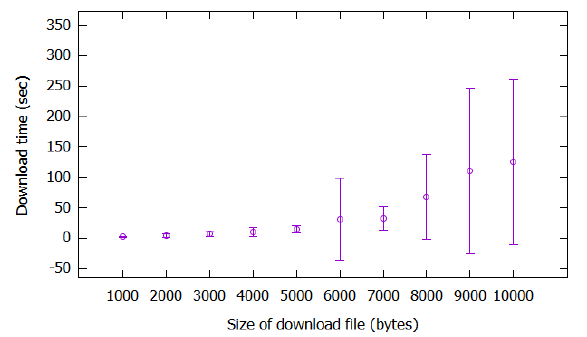
Figure 9. Comparison of average HTTP download time (error bars representing standard deviation) according to the size of the download in the range of 1,000 bytes to 10,000